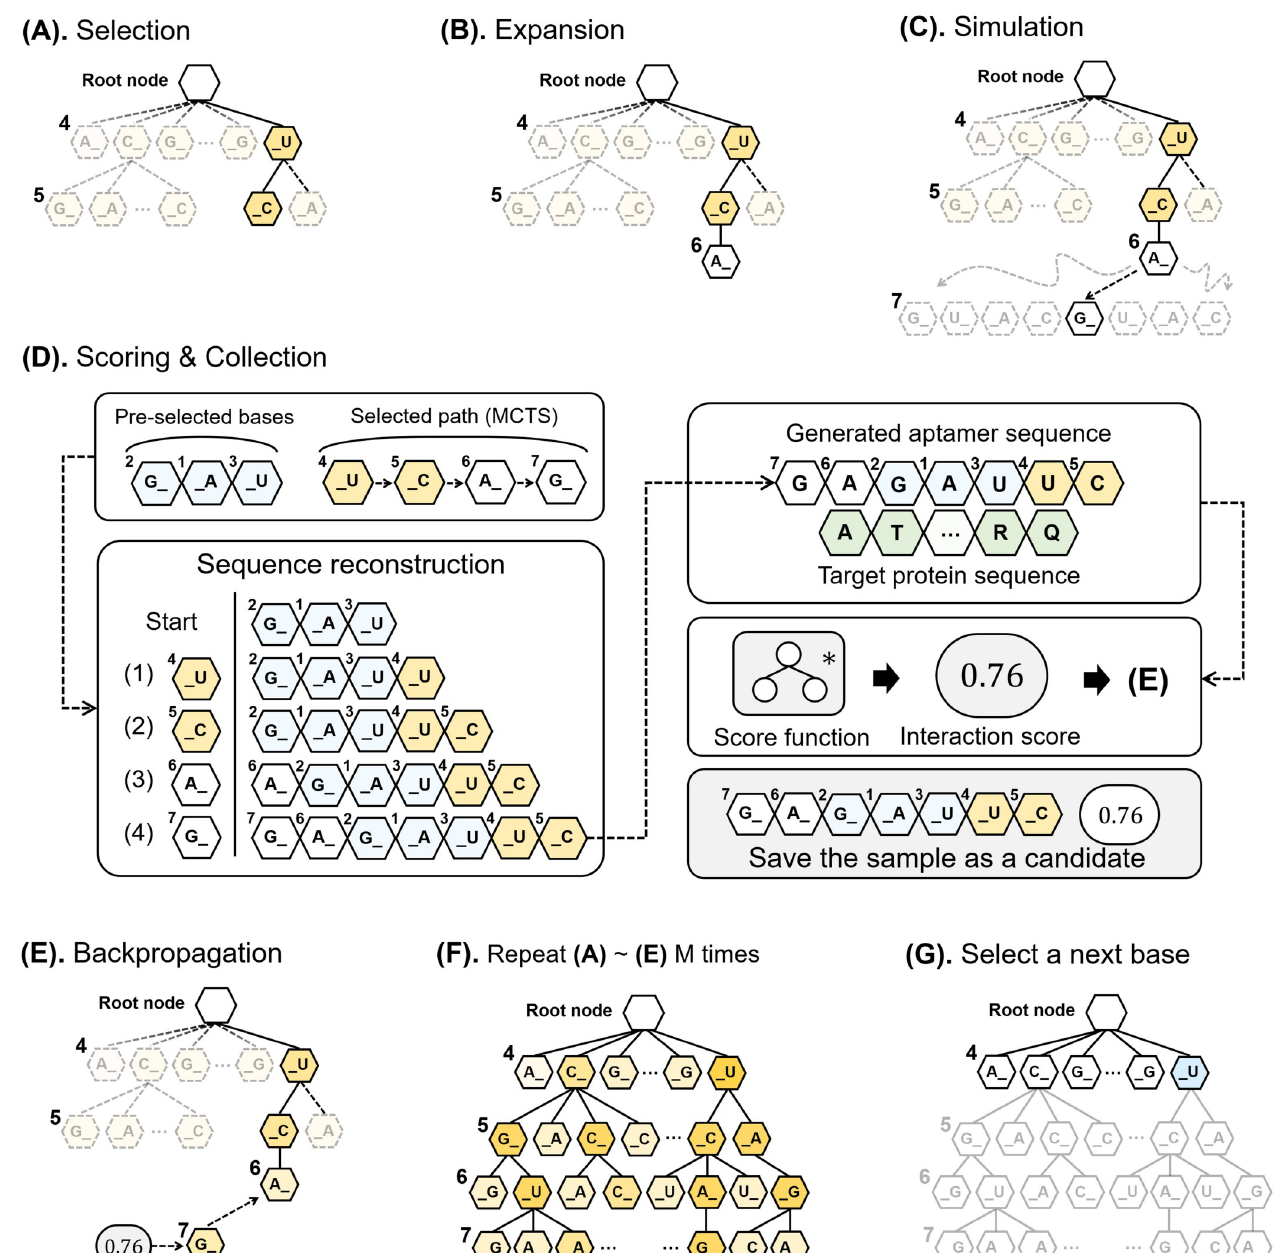
Fig 2. Details underlying our iterative forward sampling algorithm using MCTS. The process (third iteration in terms of total N ) illustrates the internal process of our sampling algorithm. (A) Selection stage of the MCTS: our method uses previously selected bases in the current sampling iteration. It searches based on the UCT score recursively and finishes after arriving at an unknown position. (B) Expansion stage: a new child node is added in the arrived node randomly from the eight child nodes. (C) Simulation stage: the algorithm attempts a random walk until tree depth N and pursues the path from root node to the leaf node. (D) The previous bases (1, 2, 3) and bases of the path (4, 5, 6, 7) are reconstructed as a candidate aptamer sequence. The sequences and interaction scores are added into a set of candidate aptamers. (E) MCTS updates the parameters of the tree using the score calculated in (D). (F) MCTS algorithm repeats the process of (A) to (E) M times. (G) The optimal base is selected from the child nodes of a root node for the next sampling iteration.